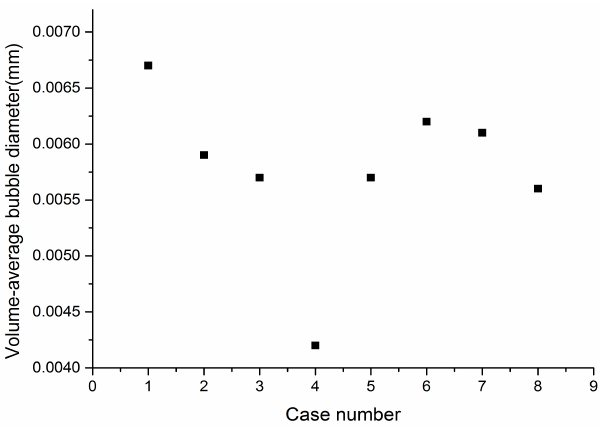
Figure 12. Comparison of the volume-averaged bubble diameter.